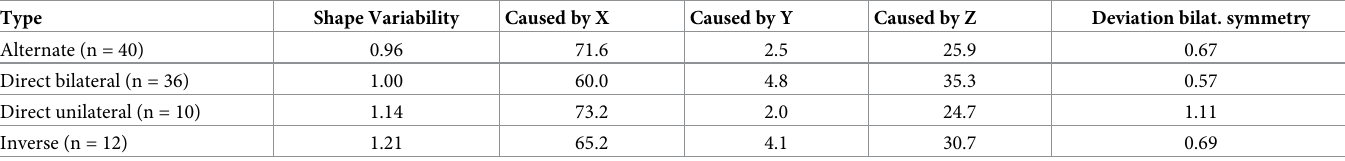
Table 6. Shape variability report across retouched bladelets sorted according to retouch position and the respective proportion (in %) caused by the three physical dimensions, as well as the deviation from bilateral symmetry computed by AGMT3-D. X represents the width, Y the length, and Z the thickness. Bilat. stands for